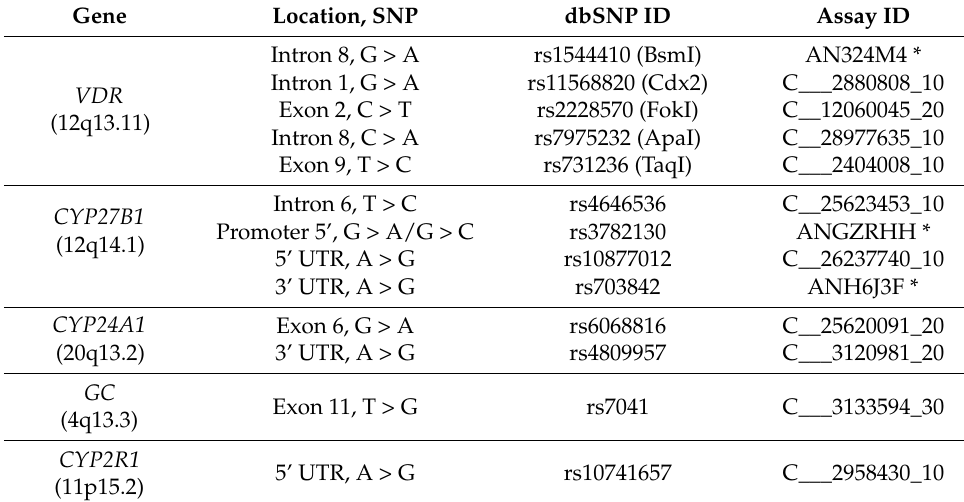
Table 5. Gene SNPs and their TaqMan Assay